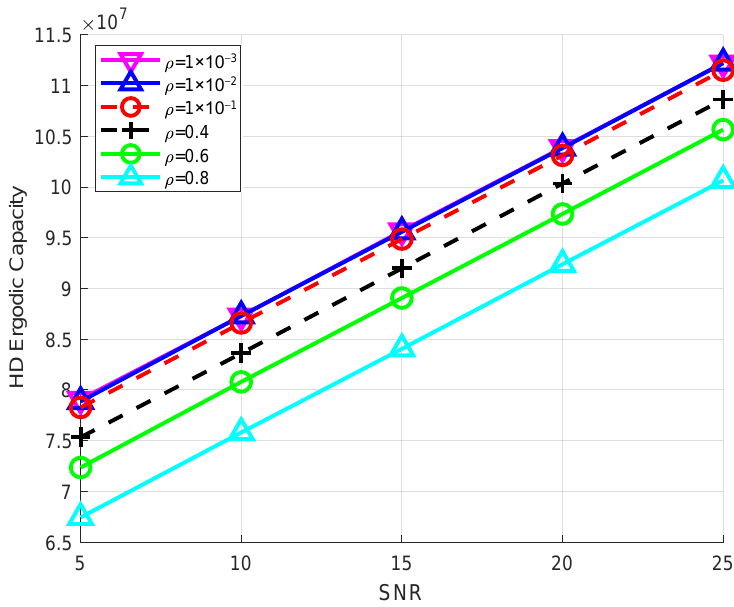
Figure 6. Capacitycomparison of half-duplex with different PS factors. The comparison of the outage probability in the half-duplex system is presented in Figure 7. When the PS factor is 0.001 to 0.1, the outage probability curves are close. With the increase of the SNR, the outage probability decreases, because when the transmit SNR increases, more capacity is obtained.